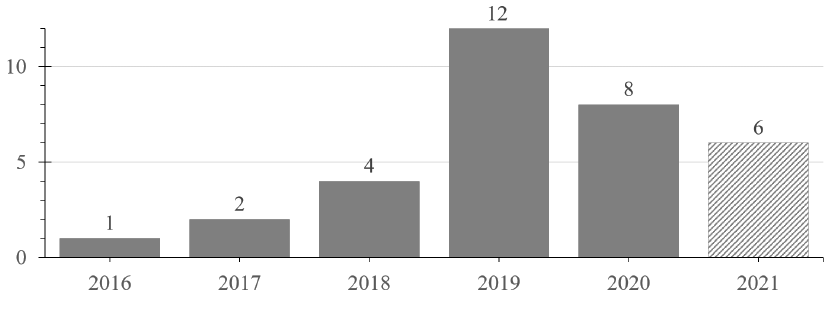
Figure 4. Publications per